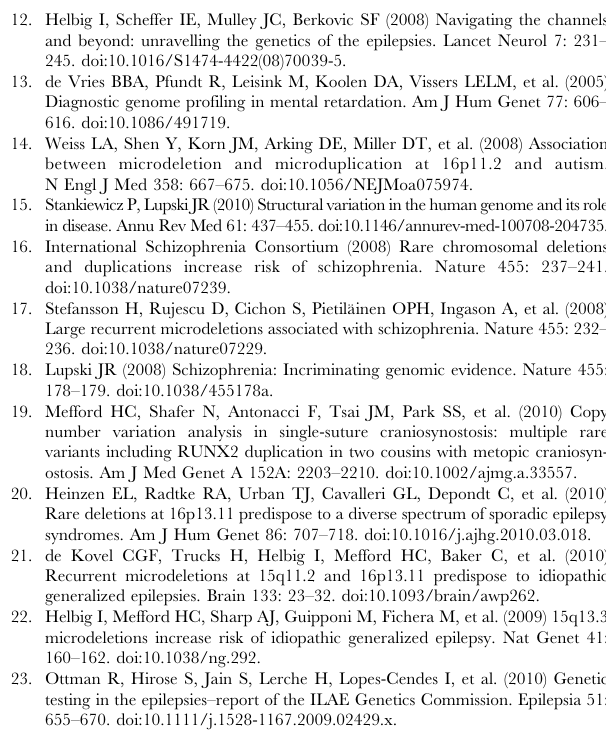
Figure S1 Efficiency of genome-wide pathogenicity scores. Each curve represents cross validation performance (see methods) of a given feature to detect 83 known epilepsy genes. Each of the colored lines represents a single feature. The bold black line represents the composite total score based on the mean of gene ontology, MGI phenotype, pathway membership, expression, miRNA, and protein-protein interaction data. The pathogenicity score is much more efficient than random chance (dotted black diagonal line) with an AUC of 0.86. Figure S2 Prioritization of candidate genes at various loci with known associations to epilepsy. Top. 1q36. Center. 2q23.1. Bottom. 16p13.11. Candidate genes with higher scoring Bayes factors are highlighted in blue. Figure S3 Pathogenicity score scaling factor for low frequency variants. The graph shows the relative influence of a gene’s pathogenicity score on its informative prior and Bayes factor calculation as a function of background deletion frequency. The red dashed line indicates the lowest frequency rate provided (i.e. those genes not identified as deleted in the non-neurologic population). The dashed blue line indicates the frequency of one subject with a deletion. The dashed green line indicates a frequency of 7 subjects among 2940 (2.4 per thousand subjects), the frequency of 16p11.2